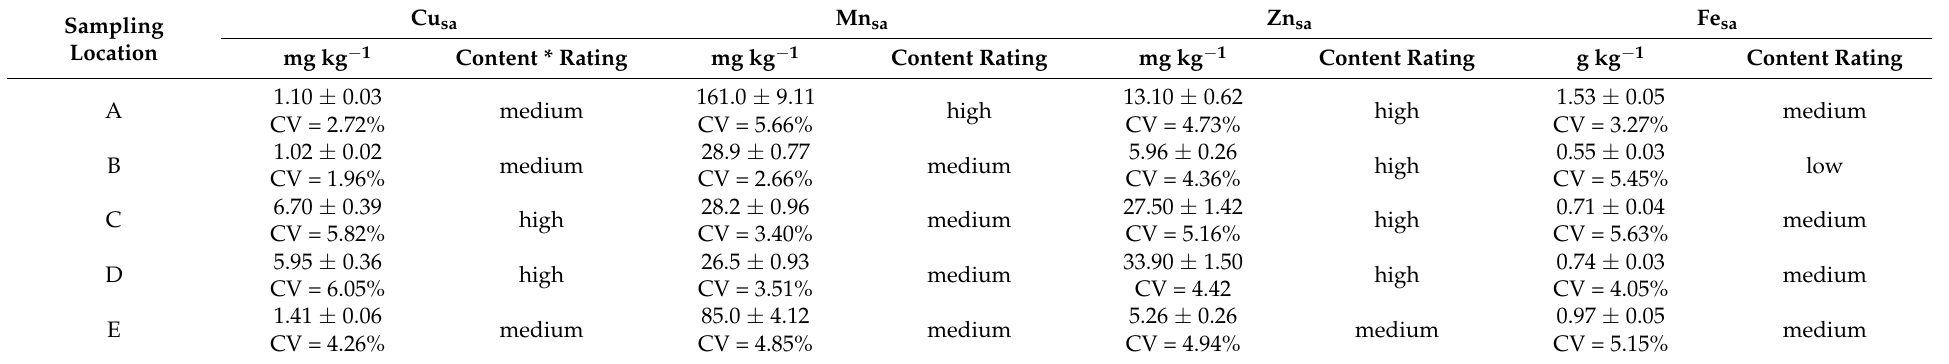
Table 2. Average content of Cu sa , Mn sa , Zn sa (mg kg − 1 ) and Fe sa (g kg − 1 ) available to plants.